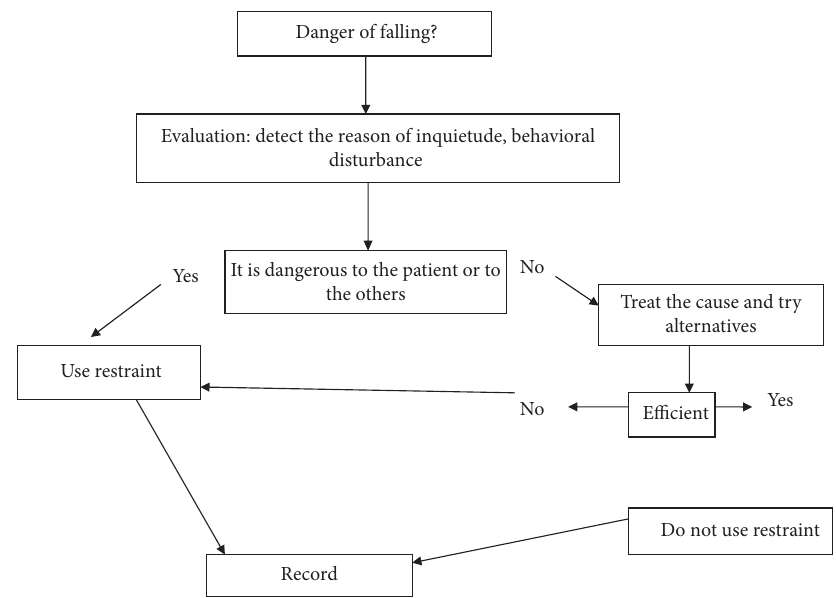
Figure 1: Decision-making algorithm for physical restraint